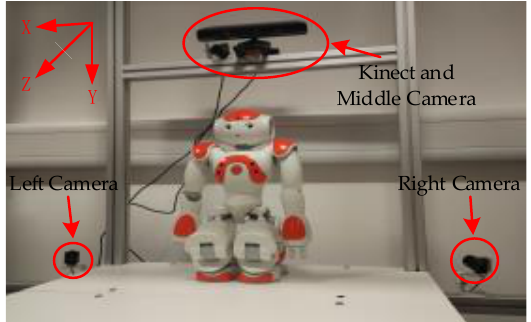
Figure 2. Relative positions among Kinect and three cameras on the framework.